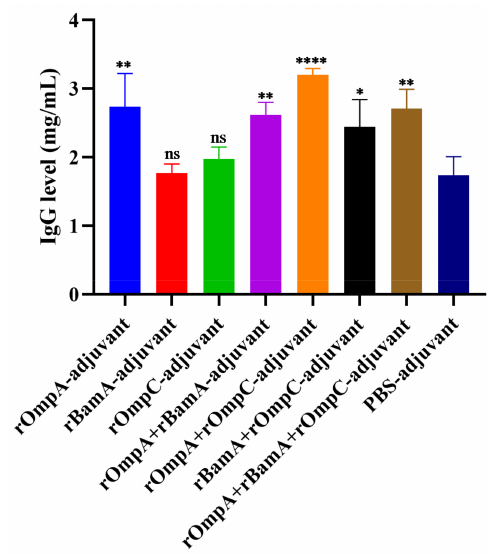
Figure 4. The level of total IgG of the antisera. Data are expressed as the means ± SD (n = 3). “*, ** and ****” indicates a significant difference between the recombinant protein immunized group and the PBS-adjuvant group (* p ≤ 0.05, ** p ≤ 0.01, **** p ≤ 0.0001). “ns” indicates that there is no significant difference between the recombinant protein immunized group and the PBS-adjuvant